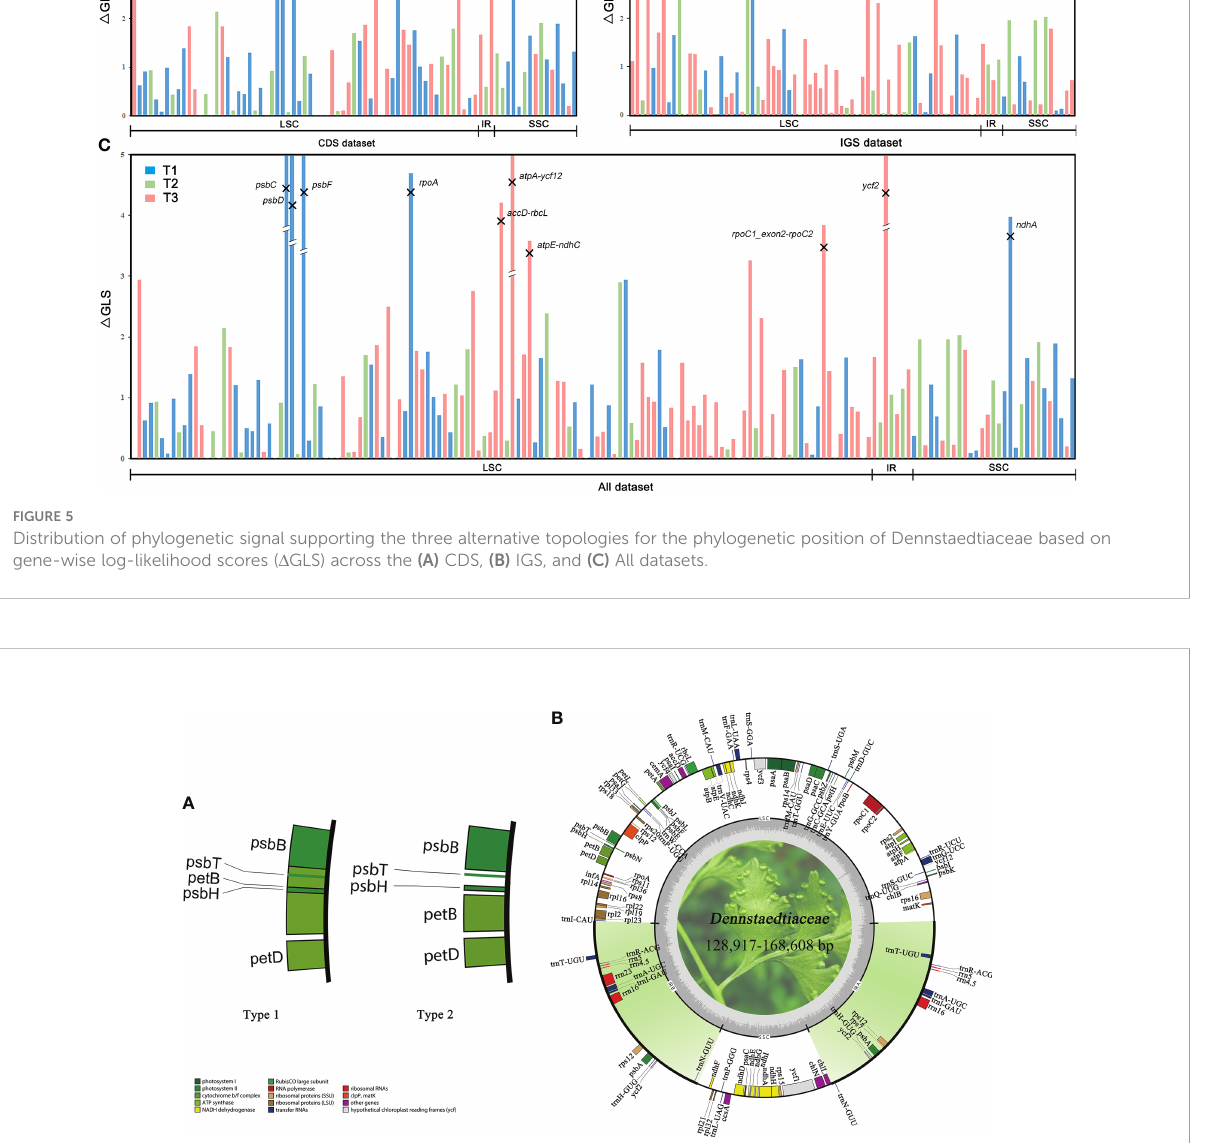
FIGURE 6 Characteristics of Dennstaedtiaceae plastomes. (A) A 4kb inversion observed in some plastomes, which was de fi ned as type 1. (B) Plastid genome map of Dennstaedtiaceae. Genes drawn inside the circle are transcribed clockwise, whereas those outside the circle are transcribed counterclockwise.